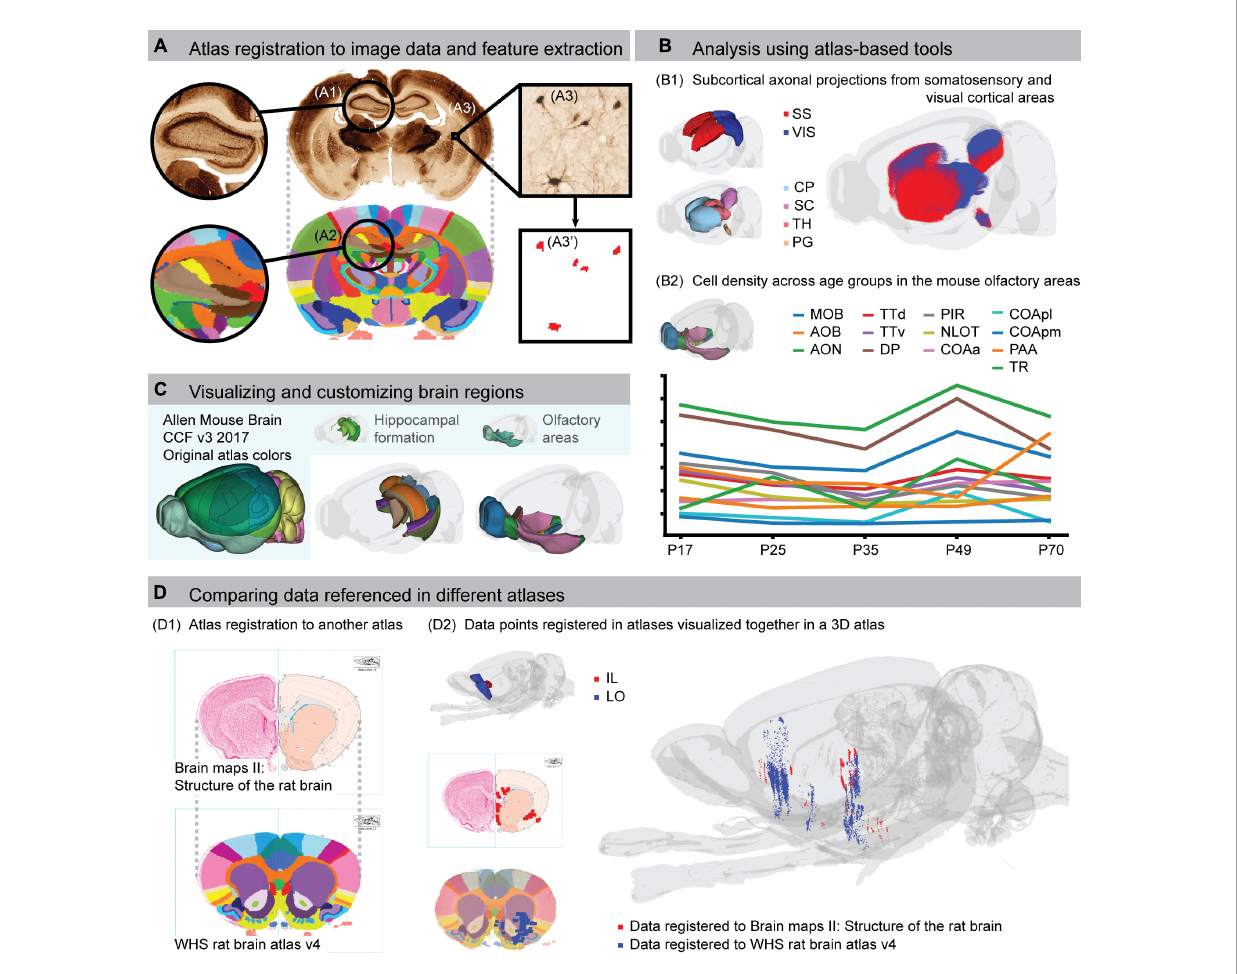
FIGURE2 Using brain atlases for spatial registration, analysis, visualization and comparison of data. (A) Example of spatial registration of a histological section to the Waxholm Space (WHS) rat brain atlas. Landmark regions, such as the hippocampus (A1,A2) , are used to find corresponding positions between the image and the atlas. Features in the images (A3) , with spatial metadata from the registration, can be extracted (A3’) . The example in (A) shows a histological image stained for parvalbumin neurons registered to the WHS atlas. (B) The principal workflow of combining atlas registration with extracted features illustrated in (A) can be used for different types of atlas-based analyses. (B1) 3D dot map visualization of corticostriatal, corticotectal, and corticopontine axonal projections originating from the primary somatosensory cortex (SS, red) and visual cortex (VIS, blue) cortical areas, extracted from anterograde tract tracing data (Oh et al., 2014) registered to the Allen mouse brain CCFv3-2017 (Ovsthus et al., 2022). (B2) Analysis of dopamine 1 receptor positive cell densities in olfactory regions of the mouse brain across five postnatal day (P) age groups [y axis values not shown, preliminary data extracted from images provided by Bjerke et al. (2022)]. (C) Visualization of customized regions from the Allen mouse brain CCFv3-2017. The left panel shows the entire atlas with the default color scheme. The middle panel shows a transparent view of the brain with regions of the hippocampal formation color coded to their corresponding region in the WHS rat brain atlas, facilitating cross-species comparisons. In the right panel, to better visualize the extent of individual regions, they are coded with contrasting colors, whereas the original atlas uses the same or highly similar colors. (D) Example of how co-registration of brain atlases supports comparison of data referenced in different atlases. The stereotaxic atlas by Swanson (1998) has been spatially registered to the WHS rat brain atlas (D1) . Data that have been extracted and mapped to the two atlases can therefore be co-visualized in the same 3D space (D2) . In this example, the red points are extracted from a previous study where retrograde projections from injections in the infralimbic cortex were represented with schematic drawing of terminal fields onto atlas plates from the Swanson atlas (Figure 8, data mirrored for comparison; Hoover and Vertes, 2007). The blue points are extracted from a public dataset showing the anterograde projections originating from the lateral orbitofrontal cortex (case F1 BDA; Kondo et al., 2022). AOB, accessory olfactory bulb; AON, anterior olfactory nucleus; CP, caudoputamen; COAa, cortical amygdalar area, anterior part; COApl, cortical amygdalar area, posterior part, lateral zone; COApm, cortical amygdalar area, posterior part, medial zone; DP, dorsal peduncular area; IL, infralimbic cortex; LO, lateral orbitofrontal cortex; MOB, main olfactory bulb; NLOT, nucleus of the lateral olfactory tract; PAA, piriform-amygdalar area; PG, pontine gray; PIR, piriform area; SC, superior colliculus; SS, somatosensory area; TH, thalamus; TR, postpiriform transition area; TTd, taenia tecta dorsal part; TTv, taenia tecta ventral part; VIS, visual